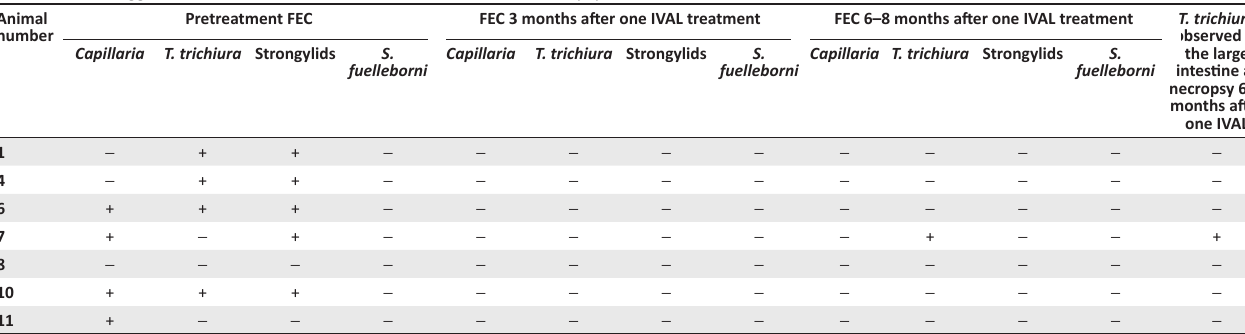
TABLE 2: Faecal egg count results and adult Trichuris trichiura found at necropsy in animals treated with ivermectin and albendazole. Animal Pretreatment FEC number